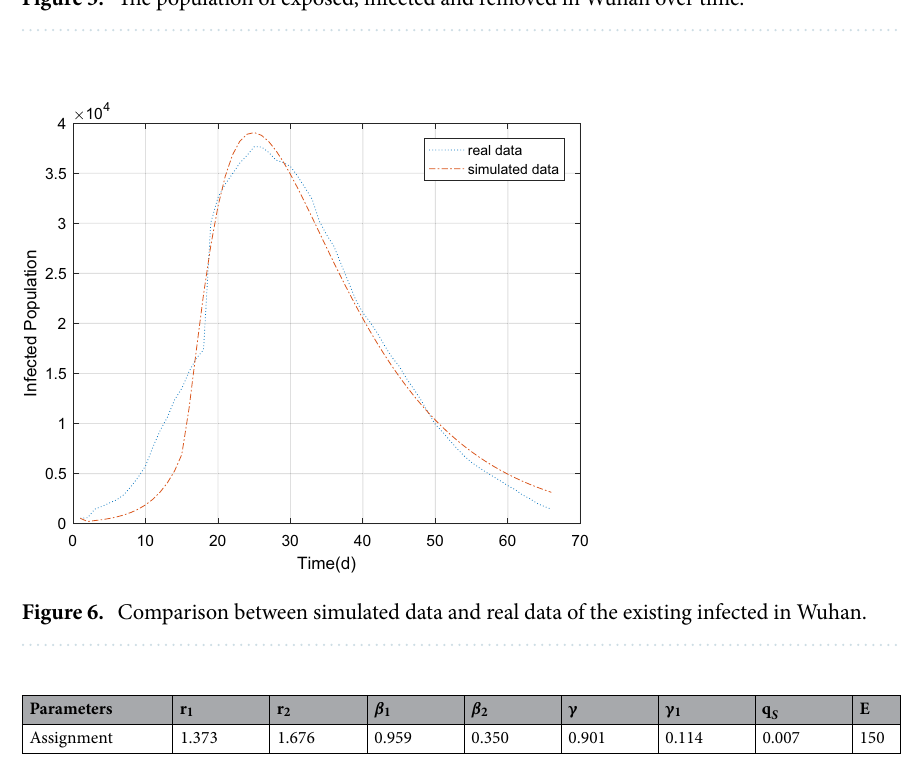
Figure 5. The population of exposed, infected and removed in Wuhan over time.